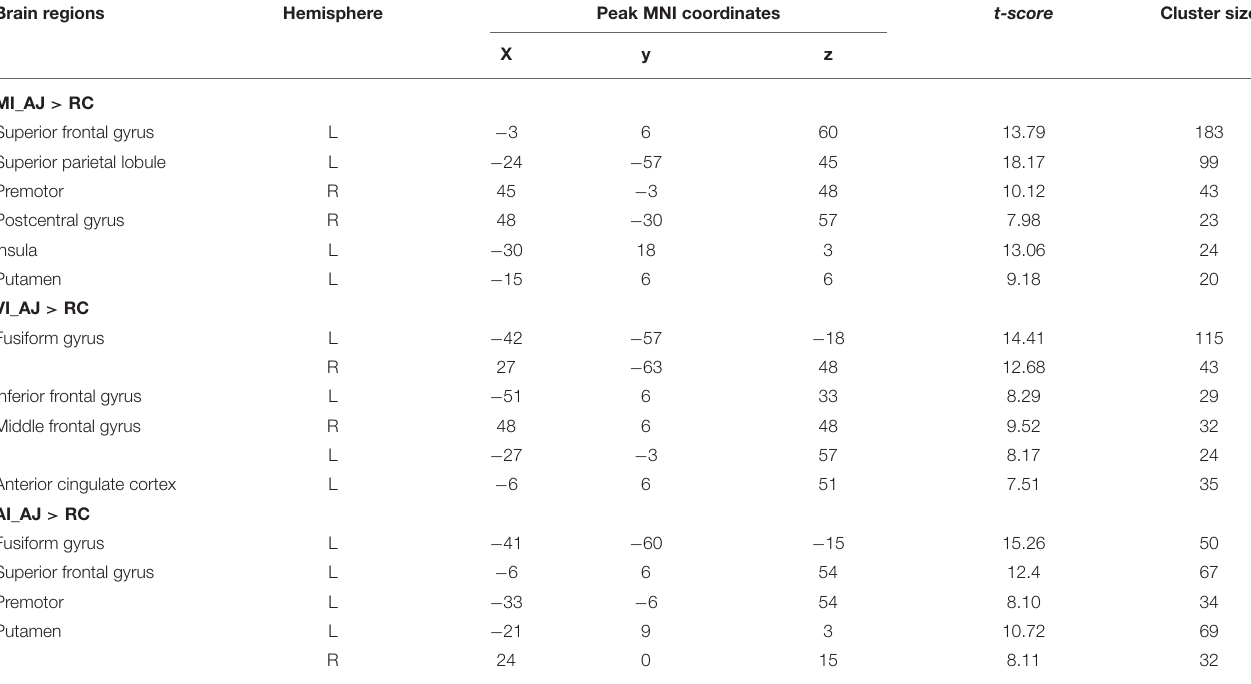
TABLE 2 | Brain activated during aesthetic judgment for the contrast kinesthetic/visual/automatic imagery vs. baseline. Brain regions